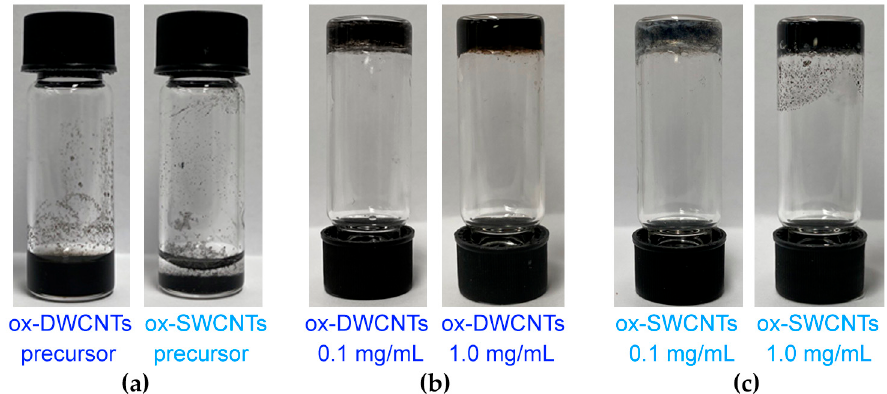
Figure 6. Photographs of peptide and CNTs in sodium phosphate solutions. ( a ) Gel-precursor alkaline solutions with peptide and CNTs. ( b , c ) Self-supporting hydrogels were obtained with peptide and ( b ) ox-DWCNTs or ( c ) ox-SWCNTs at a neutral pH. Table 2. Viscoelastic properties of the peptide hydrogels without and with ox-CNTs. Hydrogel